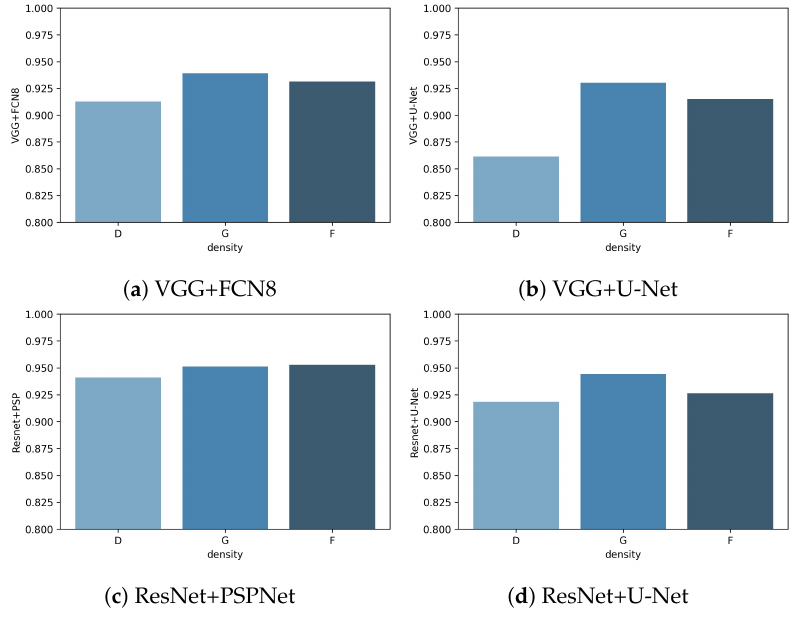
Figure 14. Jaccard index for each architecture by density